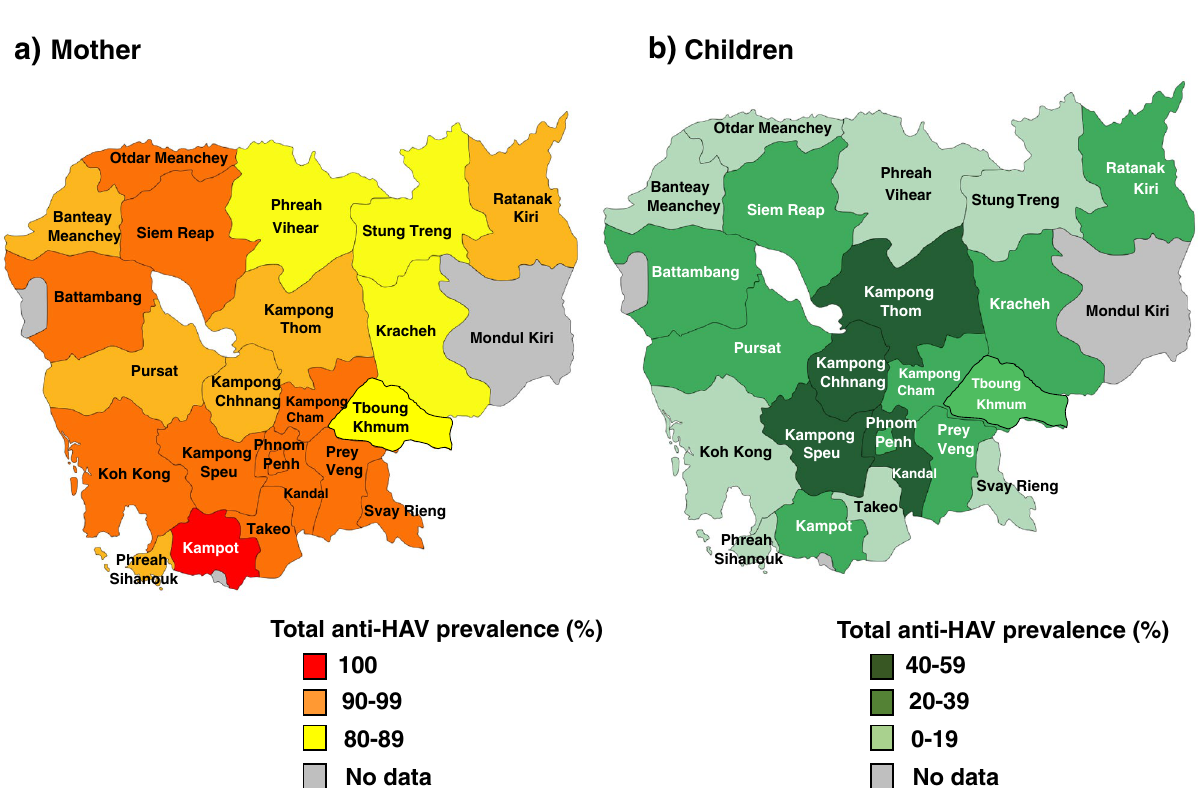
Figure 2. Population density and total anti-HAV prevalence of mother and their child in each province of Cambodia ( a ) represents the map showing total anti-HAV prevalence of mothers in each province of Cambodia in 2017 and similarly ( b ) shows for the children. The intensity of color in each map are changed by its